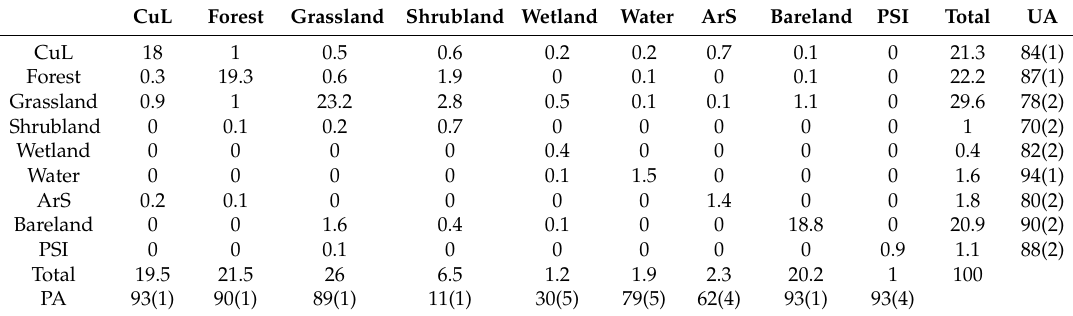
Table 7. The country-wide error matrix, cell entries are expressed as percent of area (see Table 5 for meanings of CuL, ArS, and PSI). Agreement is defined as a match between the map class and either